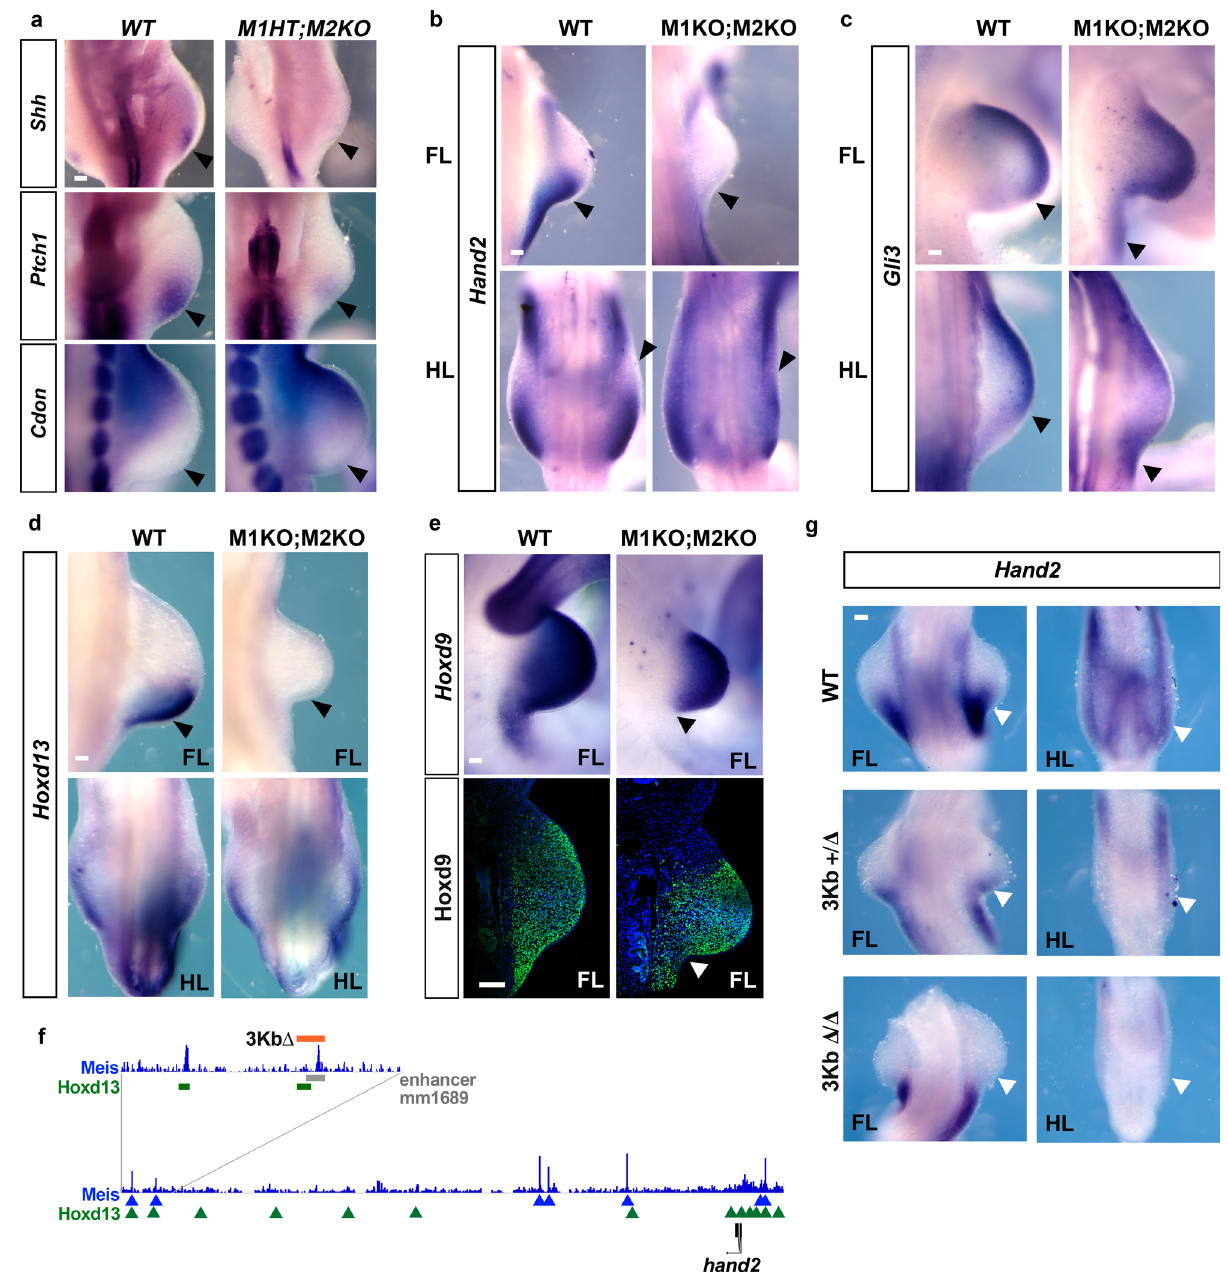
Fig. 7 Meis function in limb-bud AP prepatterning. a Whole-mount in situ hybridization analysis of Shh and its targets Cdon and Patched1 ( Ptch1 ) in WT and M1HT;M2KO HLs at E10. Limbs analyzed: N = 4, N = 4, and N = 2, respectively. Whole-mount in situ hybridization analysis of the expression of Hand2 ( b ) ( N = 6 FLs and N = 6 HLs), Gli3 ( c ) ( N = 2 FLs and N = 2 HLs), Hoxd13 ( d ) ( N = 8 FLs and N = 8 HLs) and Hoxd9 ( e , upper panels) ( N = 4 FLs) at E10.5 in WT and M1KO;M2KO FLs and HLs. Scale bars = 100 μ m. ( e lower panels) HOXD9 immuno fl uorescence in E10.5 FLs ( N = 3 FLs). Scale bar = 100 μ m. f Map of the Hand2 locus with its regulatory regions and ChIP-seq signal for Meis and HOXD13 64 . The position of the mm1689 enhancer (gray bar), the associated Meis and HOXD13-binding sites (blue peaks and green bar, respectively), and the 3 kb region deleted (orange bar) are shown in a zoomed region. g Whole-mount in situ hybridization analysis of Hand2 at E10 in embryos carrying the 3 kb regulatory region deletion ( N = 4 homozygous FLs and HLs and N = 4 heterozygous FLs and HLs). Arrowheads point to protein or gene expression downregulation. Source images are available at Mendeley Data 80